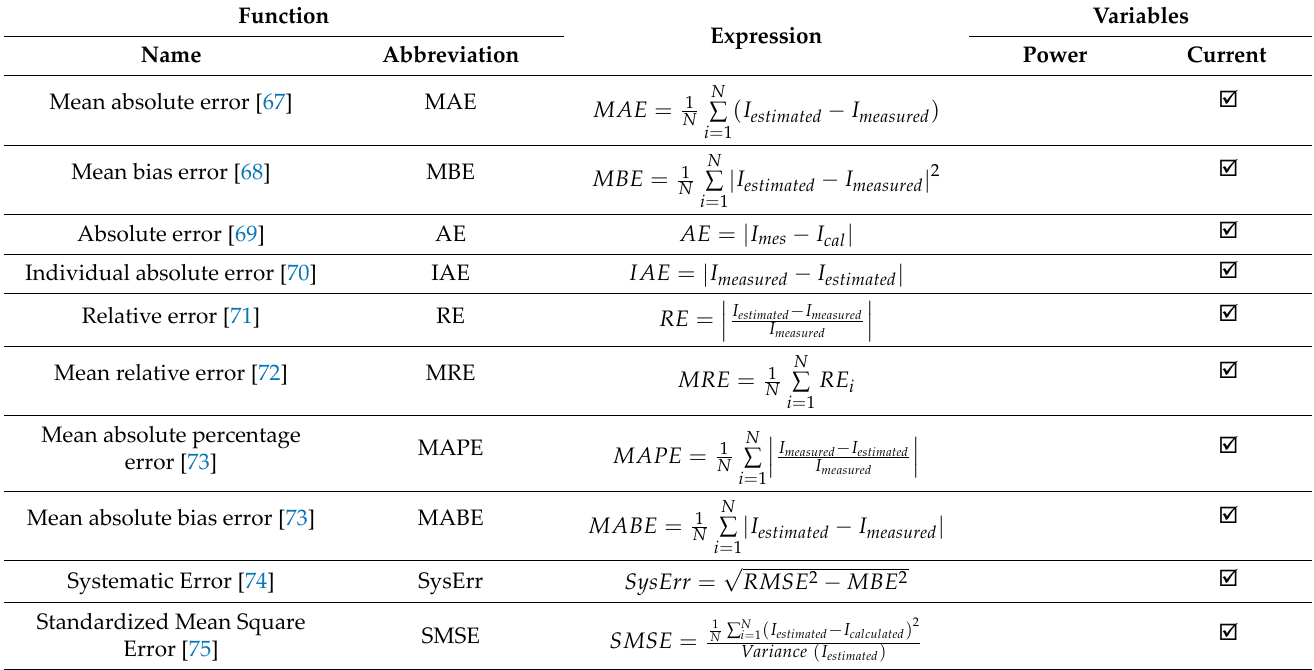
Table 3. Cont. Table 3. Formulas of error functions used in objective function formulation.